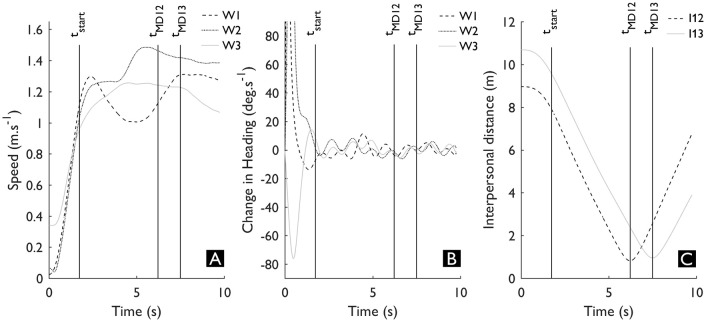
An exemplar trial showing the speed (A), change in heading (B) of each walker, and interpersonal distances (C) between W1 & W2 and between W1 & W3. The speed (A) during a trial was used to identify tstart, which corresponds to the instant the variable initiation phase was finished (B). The interpersonal distances (C) were used to derive tMD.